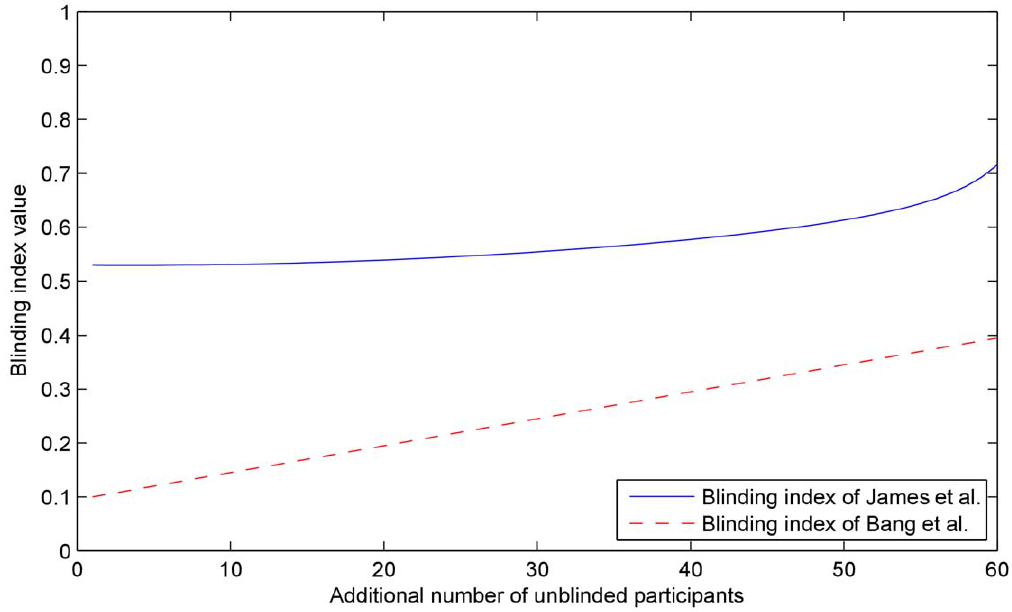
Figure 10. Experiment 4. The values of the blinding indexes proposed by James et al. (blue line) and Bang et al. (red line), computed at each step of the progressive unblinding of the participants assigned to the treatment group. While both indexes again dramatically change in value, interestingly they also show disagreement on the direction of change in blinding. This is a consequence of the difference in the underlying assumptions used to interpret the participants’ auxiliary data. Compare this with the robustness of the proposed approach in Figure 9.